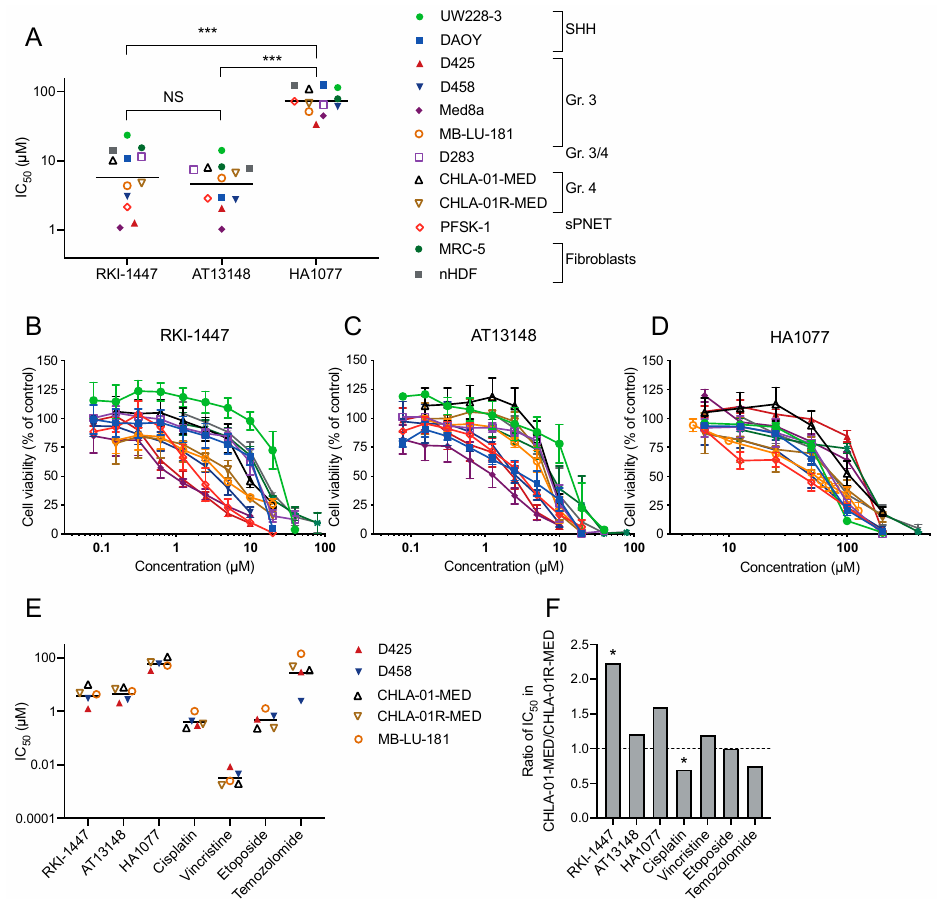
Figure 2. Pharmacological ROCK inhibition suppresses medulloblastoma growth. ( A ) IC 50 ( µ M) for ROCK inhibitors RKI-1447, AT13148 and HA1077 in a panel of nine medulloblastoma cell lines, one sPNET cell line and two non-tumorigenic fibroblast cell lines after 72 h drug exposure. The mean IC 50 values for RKI-1447 and AT13148 did not differ but both RKI-1447 and AT13148 showed lower mean IC 50 values compared to HA1077 in cancer cell lines (one-way ANOVA p < 0.001, with Bonferroni posttest RKI-1447 vs. AT13148 p > 0.999, RKI-1447 vs. HA1077 p < 0.001 and AT13148 vs. HA1077 p < 0.001). Comparing individual cell lines showed that RKI-1447 and AT13148 were superior compared to HA1077 (one-way ANOVA with Bonferroni posttest p < 0.001). When comparing RKI-1447 and AT13148 in each cell line, AT13148 was more potent in inhibiting cell growth compared to RKI-1447 in two cell lines (DAOY and D283) (one-way ANOVA with Bonferroni posttest: DAOY: p = 0.0023, D283: p = 0.0088). RKI-1447 showed a significantly higher mean IC 50 value in the non-tumorigenic fibroblast cell lines, MRC-5 and nHDF compared to the mean IC 50 value in the medulloblastoma cell lines ( t -Test, p = 0.017). ( B – D ) Dose-response curves for cell viability after 72 h for RKI-1447, AT13148 and HA1077 treatment in the same cell line panel (identically color-coded as in A ). ( E ) IC 50 ( µ M) for ROCK inhibitors RKI-1447, AT13148 and HA1077 and the standard cytotoxic drugs cisplatin, vincristine, etoposide and temozolomide in two pairs of cell lines from primary / metastatic samples: D425 / D458 and CHLA-01-MED / CHLA-01R-MED, and one patient-derived cell line from a primary tumor but with metastatic features, MB-LU-181. ( F ) The ratio between IC 50 values from CHLA-01-MED and CHLA-01R-MED. RKI-1447 showed a significantly lower IC 50 in the metastatic cell line compared to the primary ( t -Test p = 0.034) while cisplatin produced a significantly higher IC 50 in the metastatic cell line compared to the primary ( t -Test p = 0.022). ( A – F ) Cell viability was determined with the WST-1 assay. NS = non-significant, * p < 0.05 and *** p < 0.001. All concentrations were tested in at least duplicates and the experiments were repeated at least three times, in ( A , E ) the line represents the mean and in ( B – D ) mean with S.E.M. are displayed.